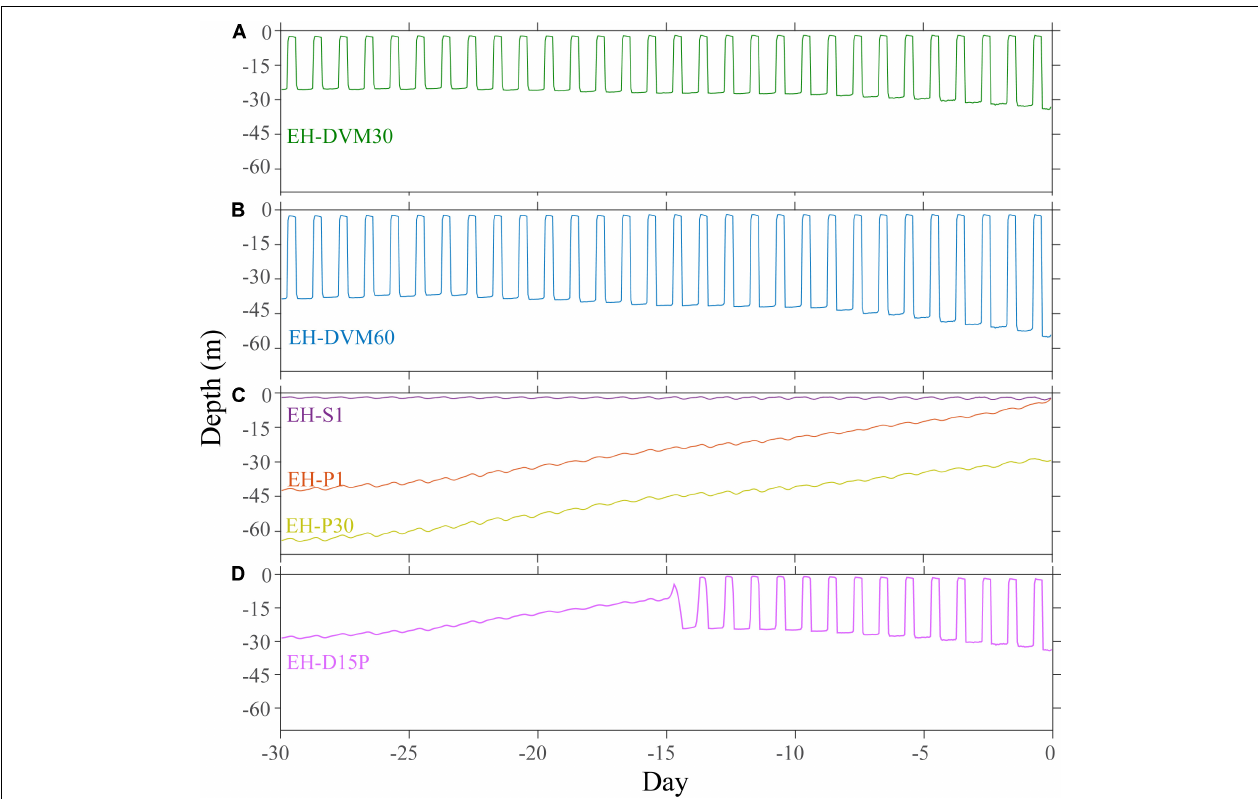
FIGURE 3 | Average depth and variability over time was driven by simulated particle behavior and initialization depth. Particles exhibiting DVM behaviors were tightly constrained between 30 m (EH-DVM30; A ) or 60 m depths (EH-DVM60; B ) and the surface. (C) Passive particles initialized at 1 m (EH-P1) and at 30 m depths (EH-P30) originated from deeper depths and traveled up in the water column over time, while surface-following particles (EH-S1) experienced a tightly constrained depth habitat near the surface. (D) These particles spent the first 15 days of the simulation exhibiting DVM between the surface and 30 m depth, and then they transitioned to passive dispersal